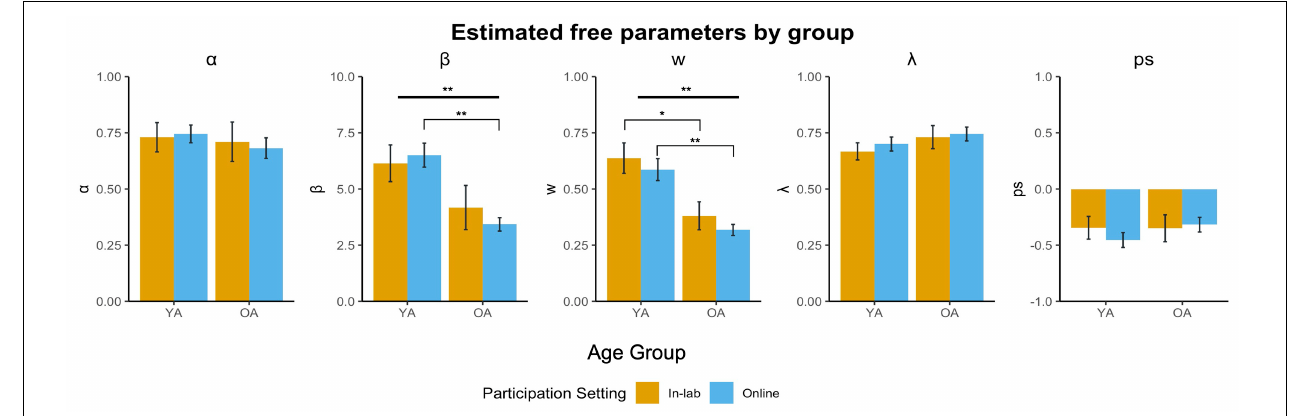
FIGURE 4 | Estimated free parameters by group. We performed 2-way ANOVAs assessing main effects of age group (young adults vs. older adults) and participation medium (in-person vs. online) for each parameter. There were no main effects of participation medium, but we found main effects of age for weight (w) and β . Bolded lines represent significant main effects, brackets represent significant pairwise comparisons (** p < 0.001, * p < 0.05).